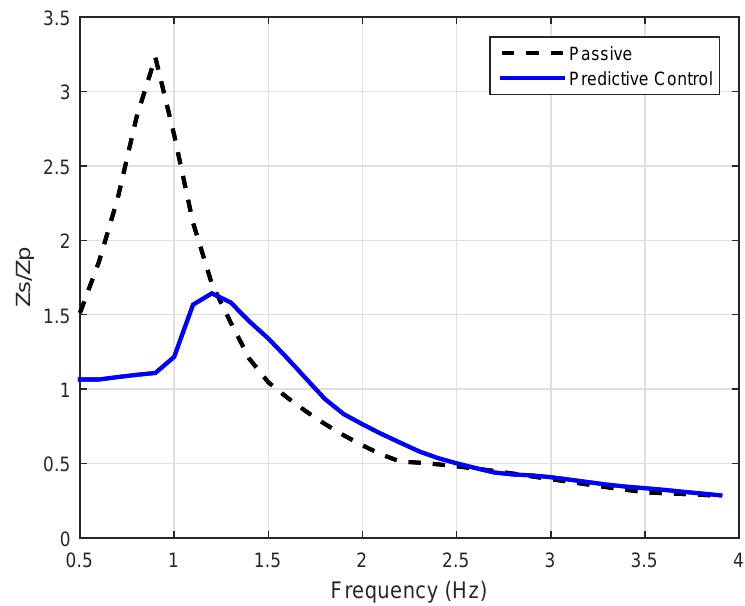
Figure 3. Sprung displacement gain ( z s / z p ) for the passive and predictive